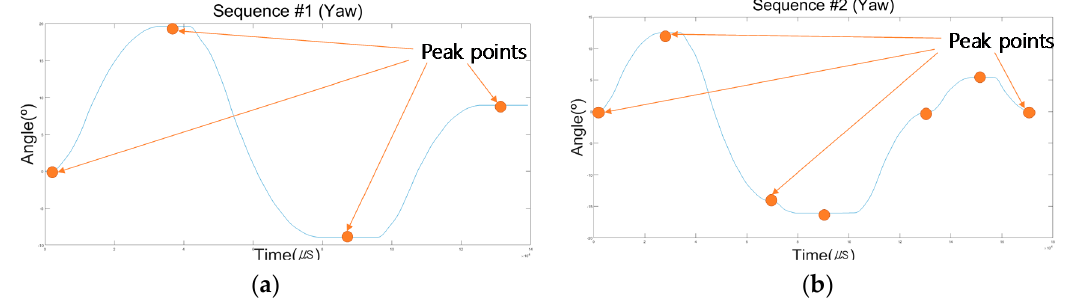
Figure 11. Sequences and peak points for simulated head orientations: the change of angles in ( a ) sequence #1 and ( b ) sequence #2.